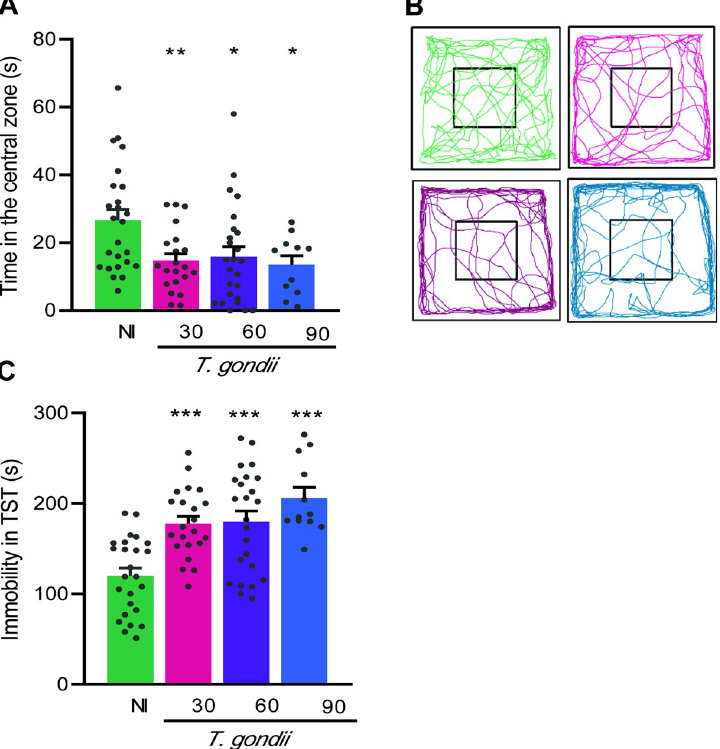
Fig 4. Anxiety and depressive-like behavior are detected in long-term chronically Toxoplasma gondii -infected C57BL/6 mice. ( A ) Chronically infected mice showed reduced time in the central zone in OFT, and ( B ) increased time exploring the peripheral area of the open field. ( C ) Depressive-like behavior was revealed as enhanced time of immobility in TST. Each experimental group consisted of 4–6 NI mice and 10–15 T . gondii-i nfected mice. Each circle represents an individual mouse. Data are expressed as means ± SEM, and were analyzed using t- Student test. � , p < 0,05, �� , p < 0.01. ��� , p < 0.001, comparing T . gondii- infected and NI mice.